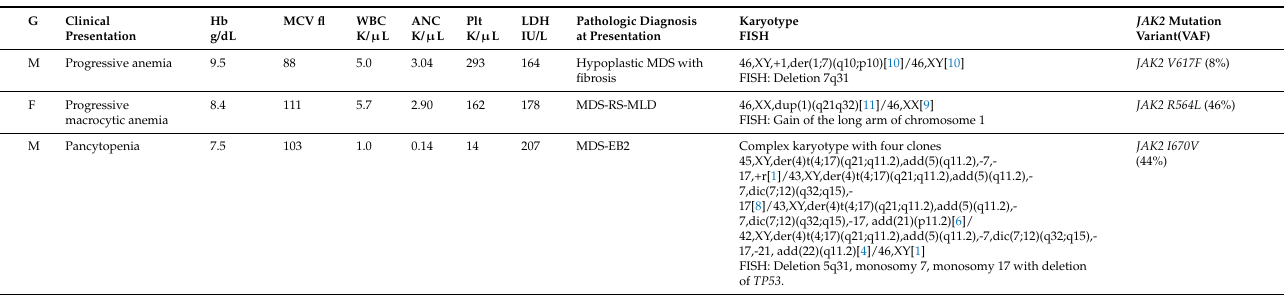
Table 2. Cases clinical and pathological